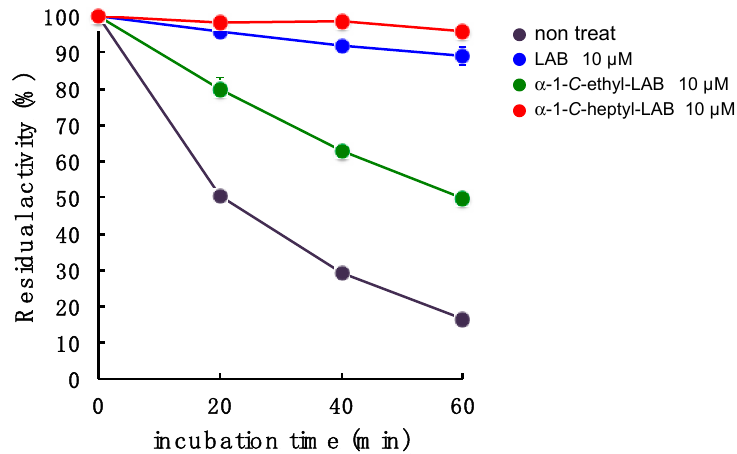
Figure 8. Effect of LAB, α -1- C -ethyl-LAB, and α -1- C -heptyl-LAB on the in vitro thermostability. GAA was incubated at 47 °C in 100 mM sodium citrate buffer (pH 6.8) containing 1 mg/mL of bovine serum albumin (BSA) at various incubation times with or without iminosugars. Each value represents the mean ± SEM ( n = 3).